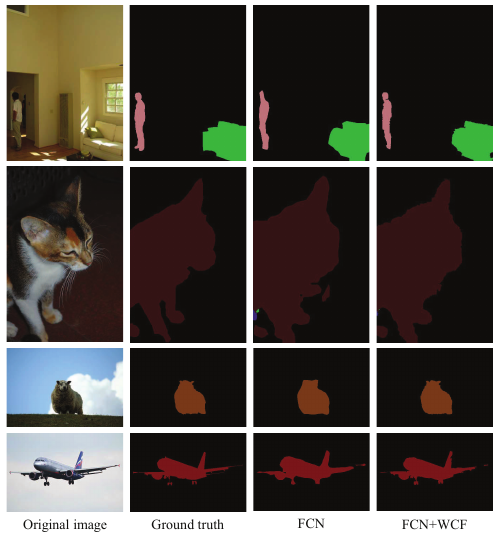
Figure 4. Enhancement of segmentation results of FCN. From the first row to the fourth row are man, cat, sheep and aircraft, respectively. From the first column to the fourth column are the original images, the ground truth of images, the preliminary segmentation results by FCN and enhancement results by the proposed methods